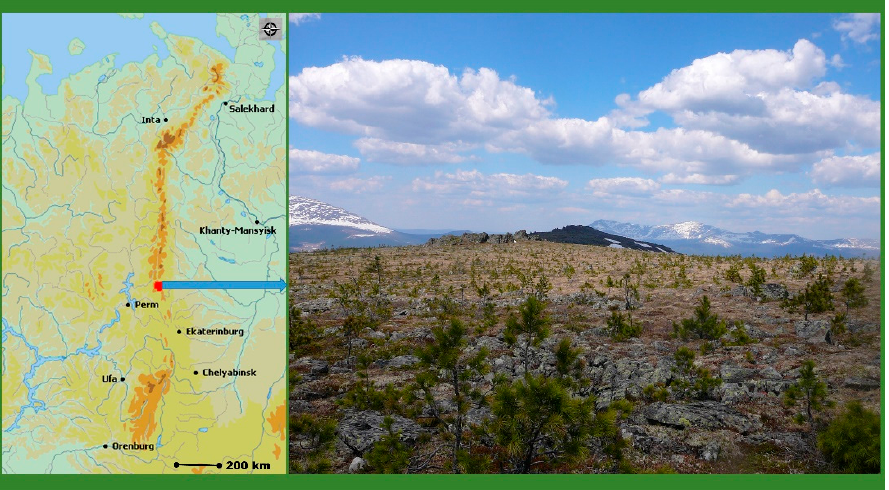
Figure 1. Study area. Source: Ural map [28], photo taken by the authors. The plateau soil horizon is 5–15 cm thick (up to 20 cm in some places), with the un ‐